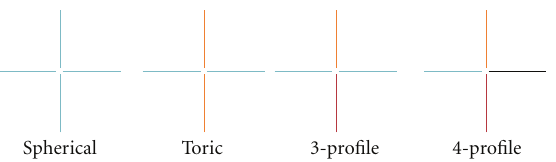
Figure 6: Diagrammatic representation of various radially symmetric and asymmetric haptic types. Each color represents a unique contour.